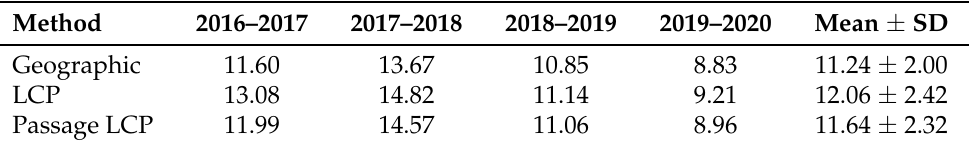
Table 4. Calculated R. nitidula spread distances (km) and their means ( ± SD) in the Odra River basin based on three methods of distance